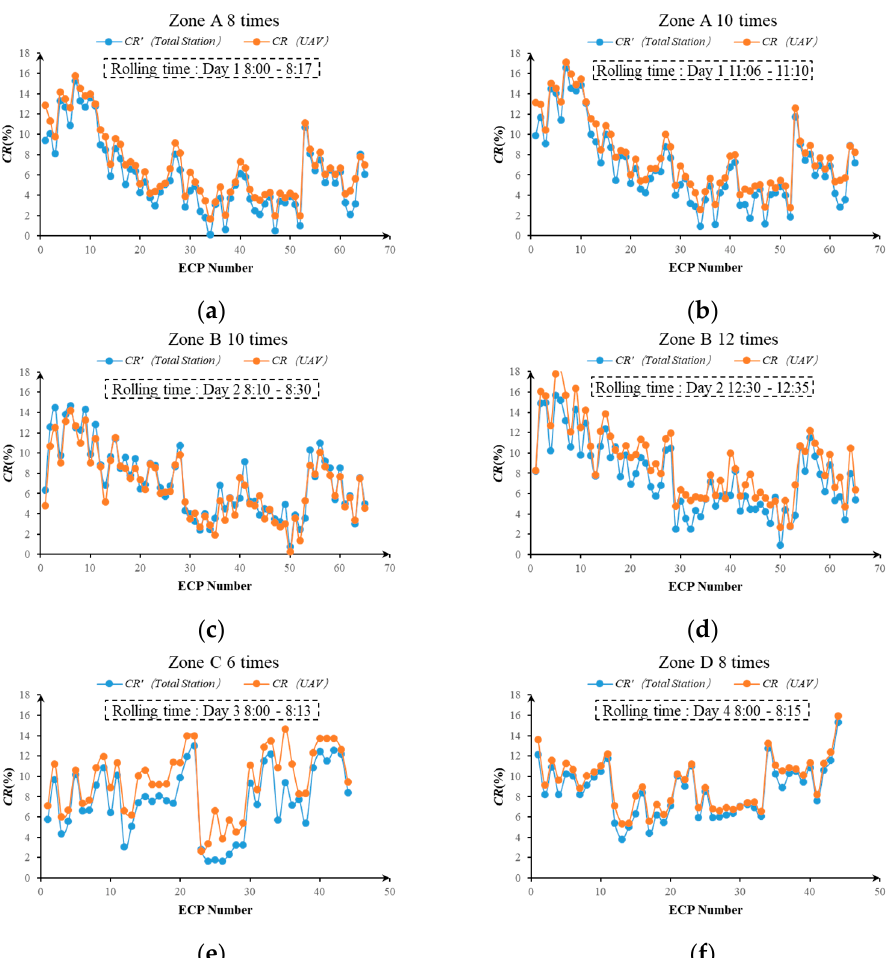
Figure 8. Comparison between CR measured by total station and UAV: ( a ) Zone A compacted 8 times; ( b ) Zone A compacted 10 times; ( c ) Zone B compacted 10 times; ( d ) Zone B compacted 12 times; ( e ) Zone C compacted 6 times; and ( f ) Zone D compacted 8 times. Table 5. Error of ECPs in subregional statistics.